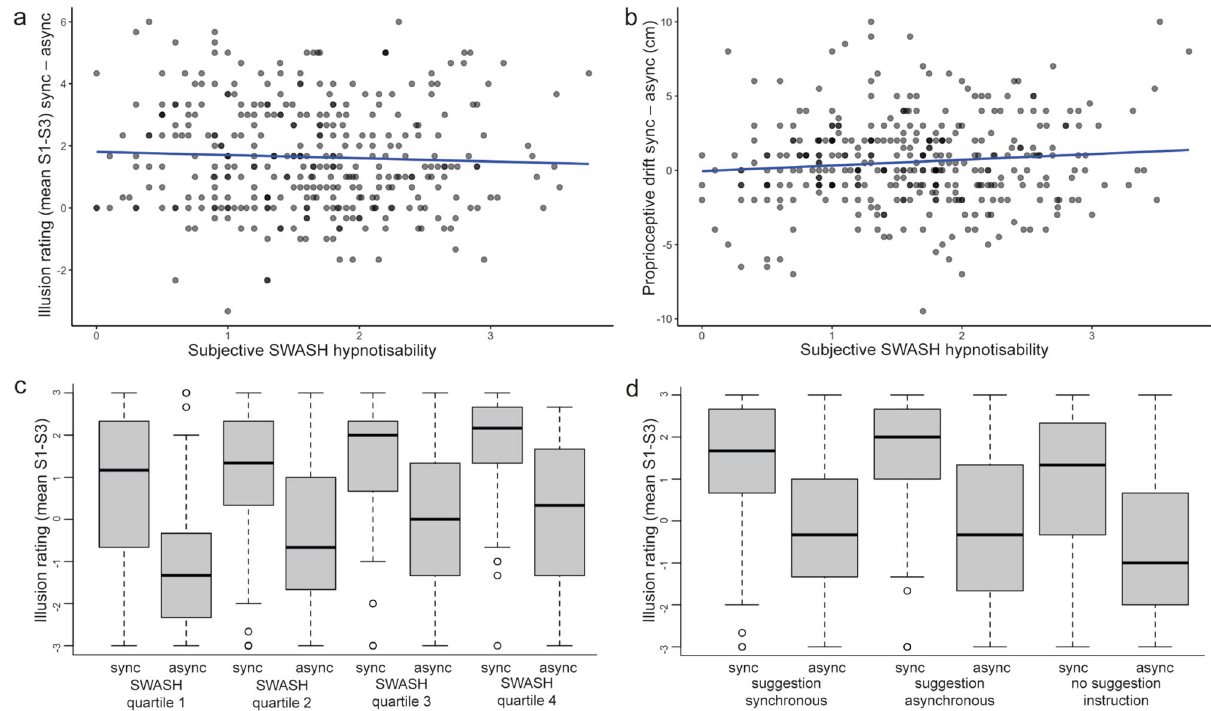
illusion ratings (mean of questionnaire statements S1 to S3) when comparing the synchronous (illusion) and asynchronous (control) conditions ( ϱ = − 0.066, p = 0.219, 95% CI [ − 0.169, 0.039], BF = 5.685, n = 353). b Similarly, there was no signi fi cant relationship between SWASH and proprioceptive drift 01